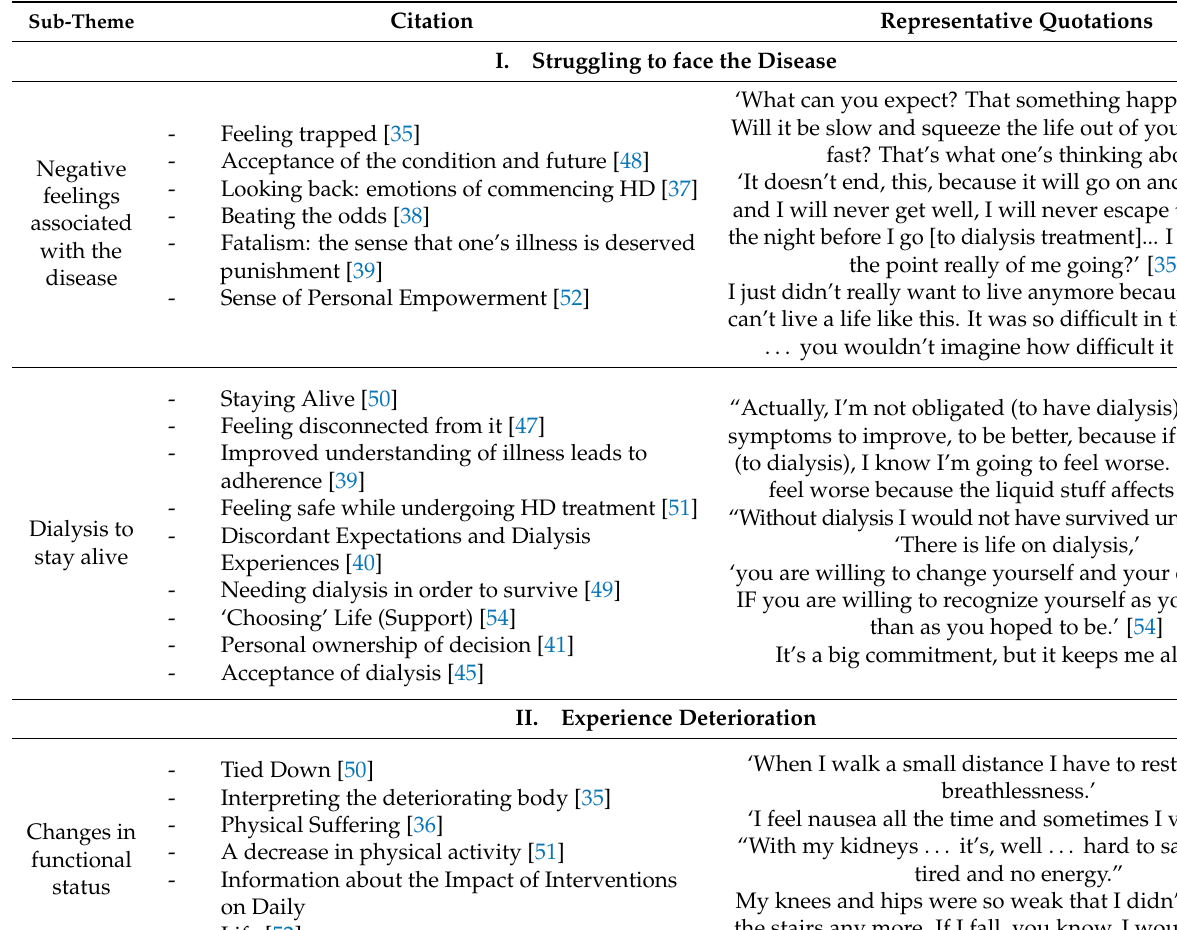
Table 3. Illustrative Quotations by